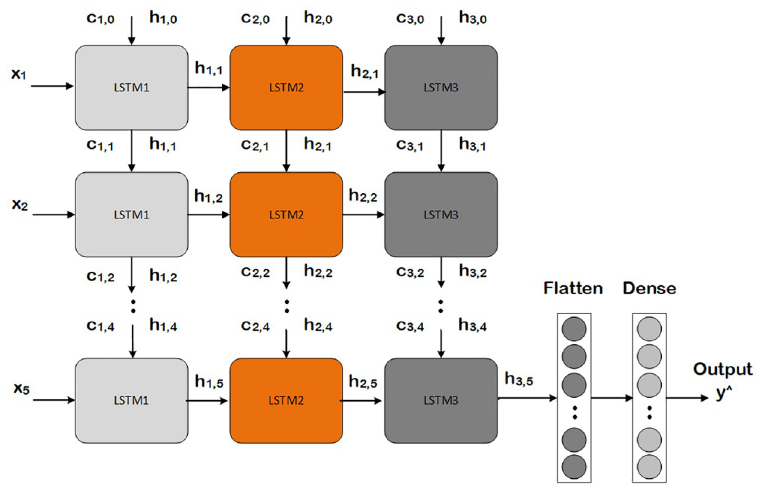
Fig 7. Proposed LSTM